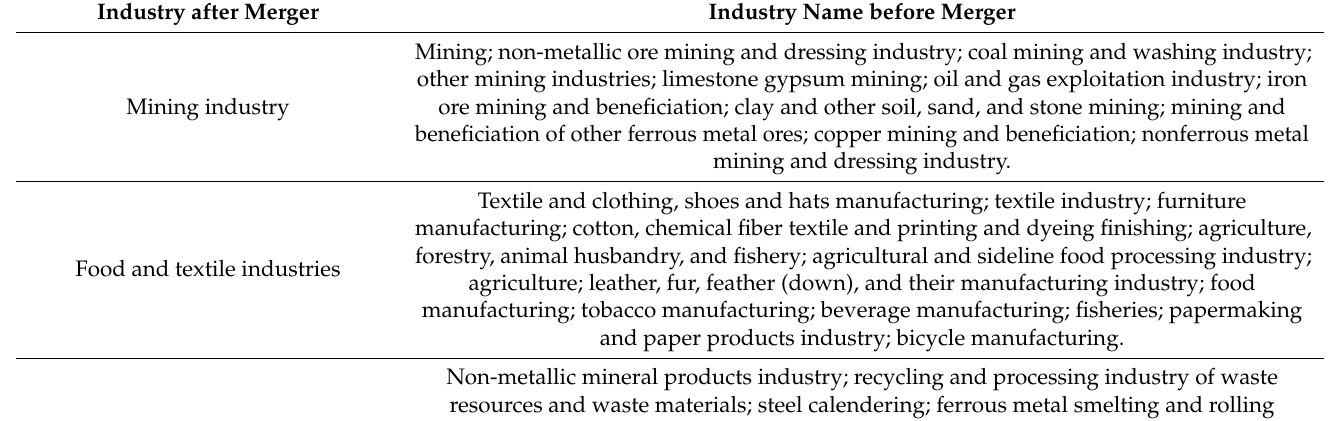
Table 1. Industry